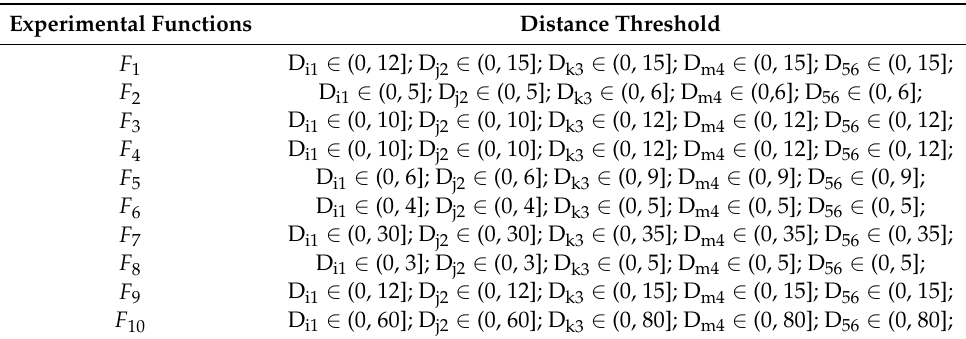
Table 4. Parameter settings of